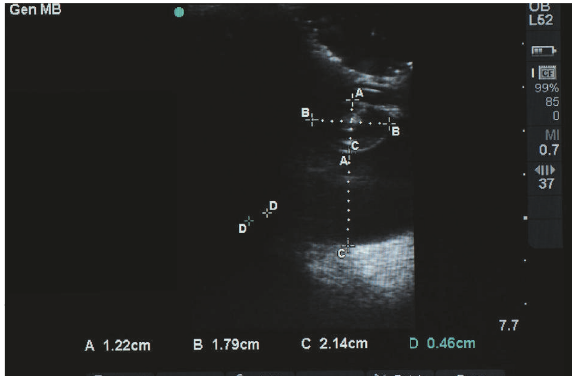
Figure 2: B-mode ocular ultrasonography of the elephant’s right eye revealing a hyperechoic nuclear lens. Despite the clinical diagnosis of a mature cataract, the lens cortex appears to be less significantly affected in the ultrasound image. The crystalline lens thickness (A: 12.2 mm), crystalline lens diameter (B: 17.9 mm), and the vitreal chamber depth (C: 21.4 mm) are visible in this image, as well. Note thatDisnotavalidmeasurementandthatthecalipermeasurements were inadvertently saved.